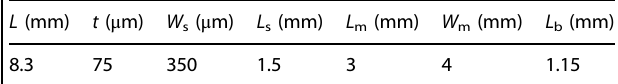
Table 1. Design parameters of capacitive seesaw-like mesostructures fabricated by the mechanics-guided